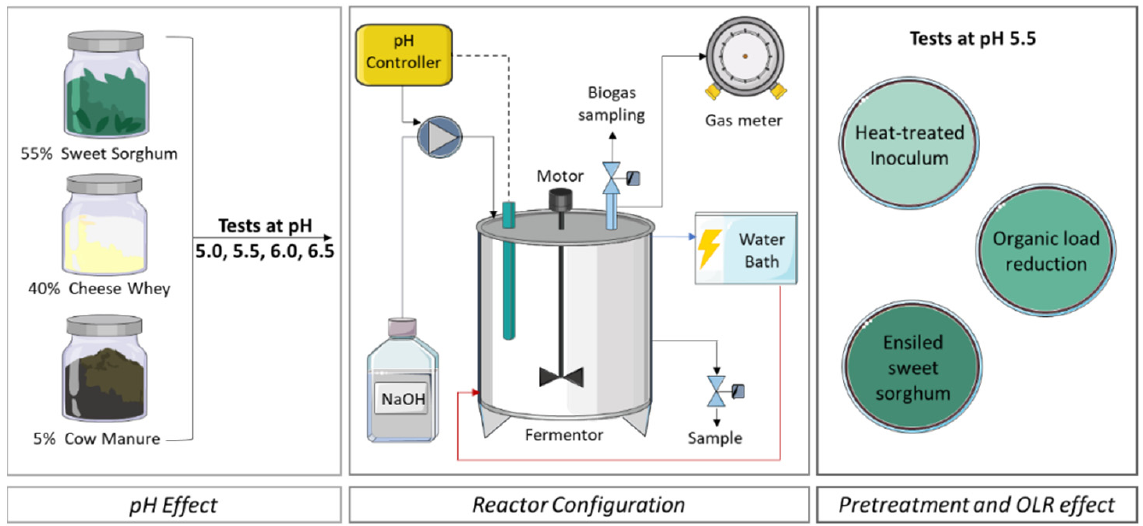
Figure 1. Reactor configuration and sets of experiments.